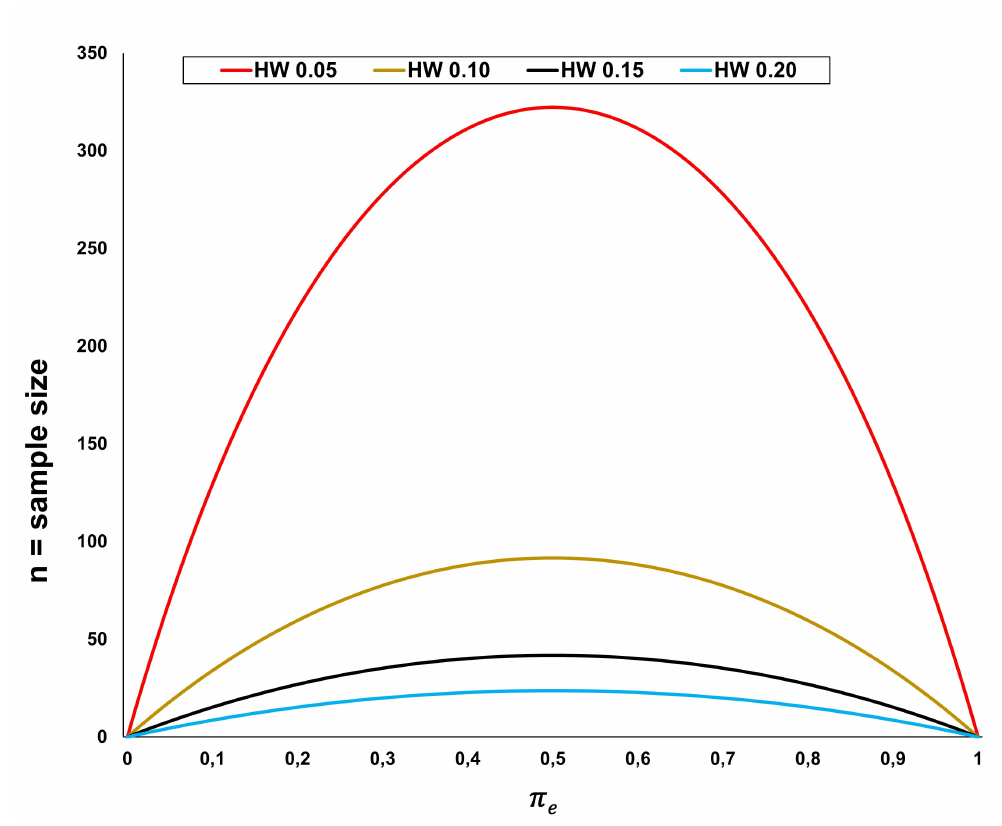
Figure 7. Sample size n for a population of 2,000, plotted against incidence π e for four different HW s , using Equation